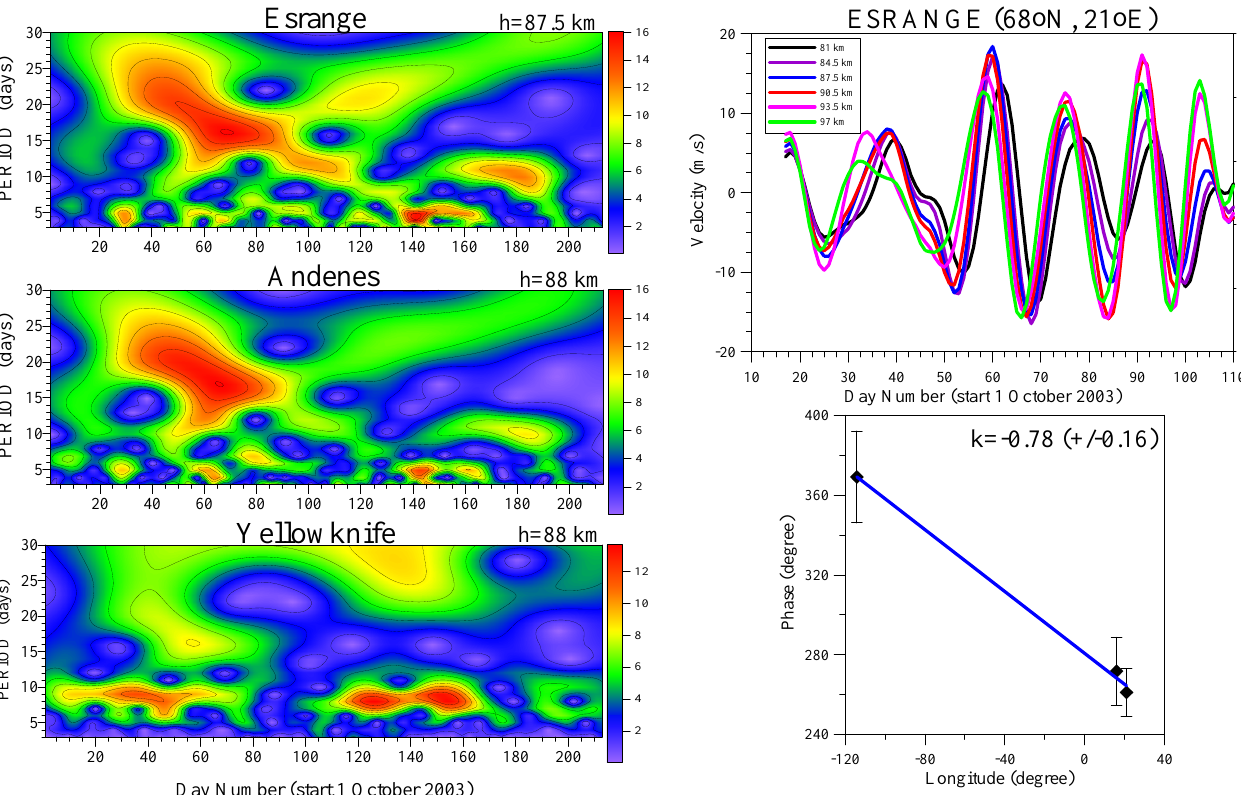
Fig. 10. Wavelet amplitude spectra (left column of plots) calculated in the period range from 3 to 30 days for the zonal wind at ∼ 88km height measured at Esrange, Andenes and Yellowknife. The right column of plots shows the 16-day filtered zonal wind data at Esrange (upper plot) and the longitudinal distribution of the 16-day wave phases (bottom